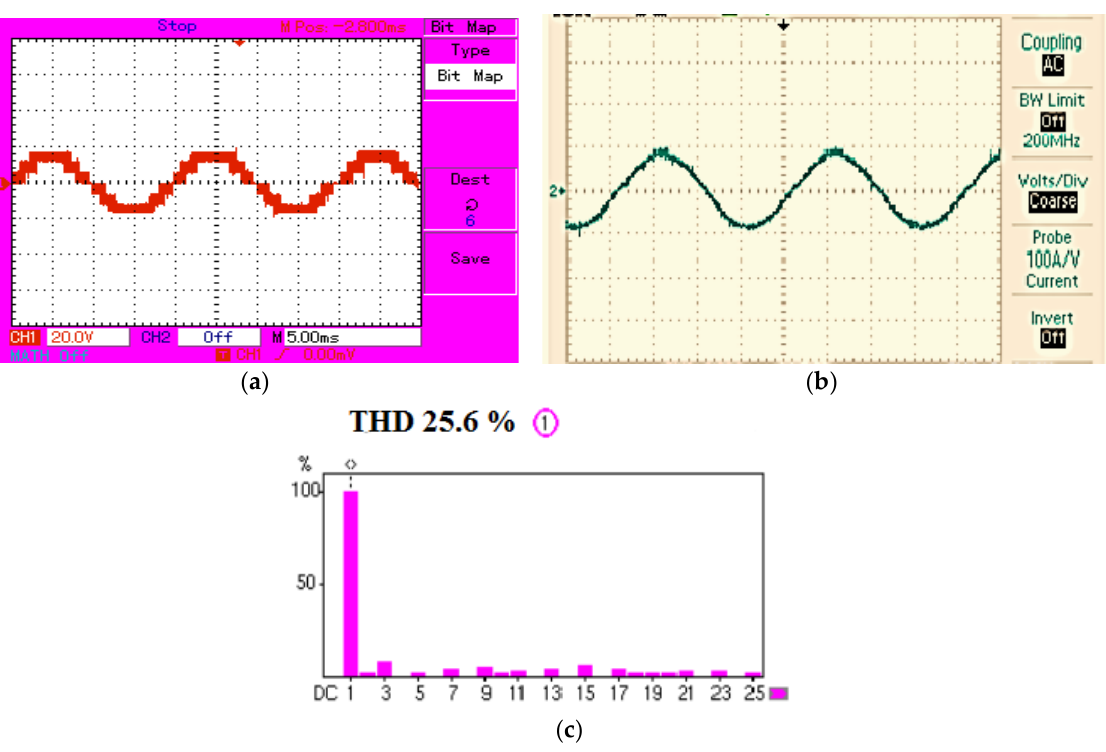
FFT plot for the output voltage.